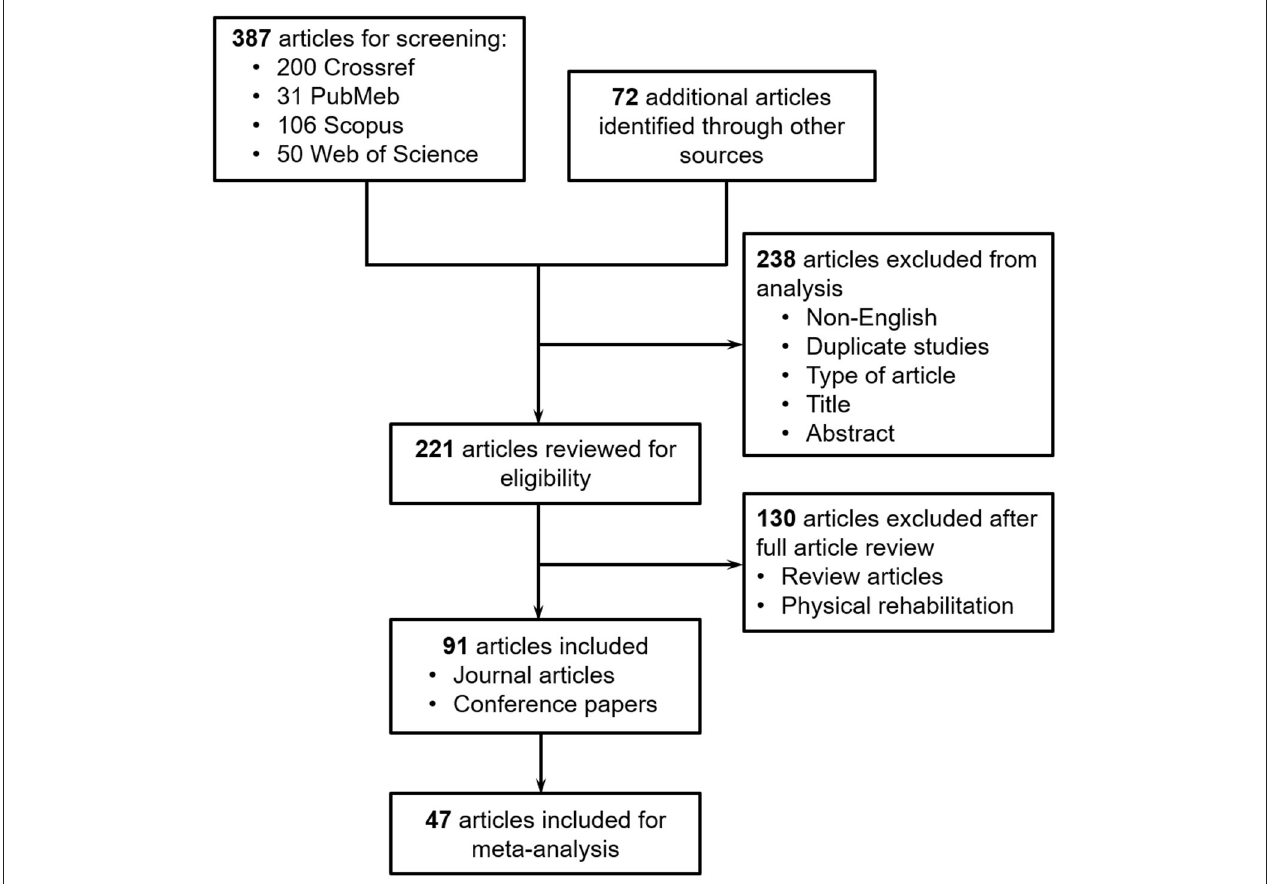
FIGURE 1 | PRISMA flow diagram illustrating the exclusion criteria and stages of the systematic